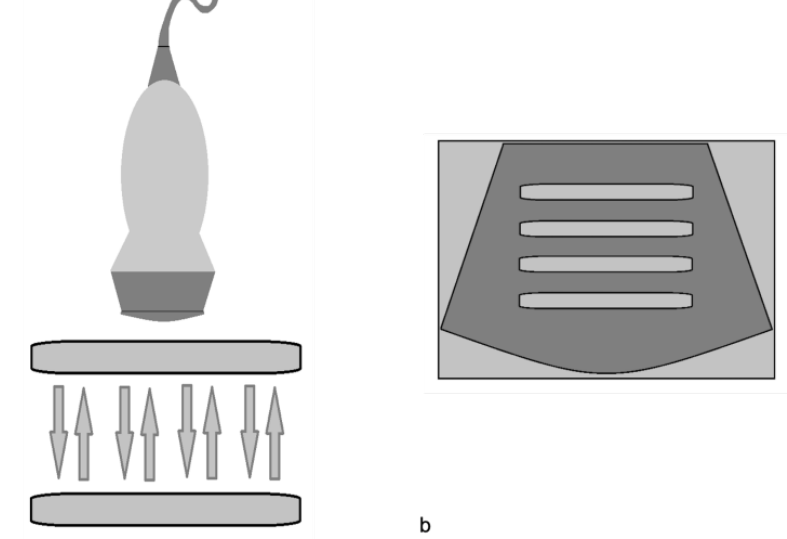
Figure 10. Reverberation artifact. ( a ) Diagram shows ultrasound echoes reflect back and forth between two highly reflective interfaces (“reverberates”) ( b ) The display shows multiple equally spaced signals extending into the deep field. Modified from Feldman MK et al. [5].